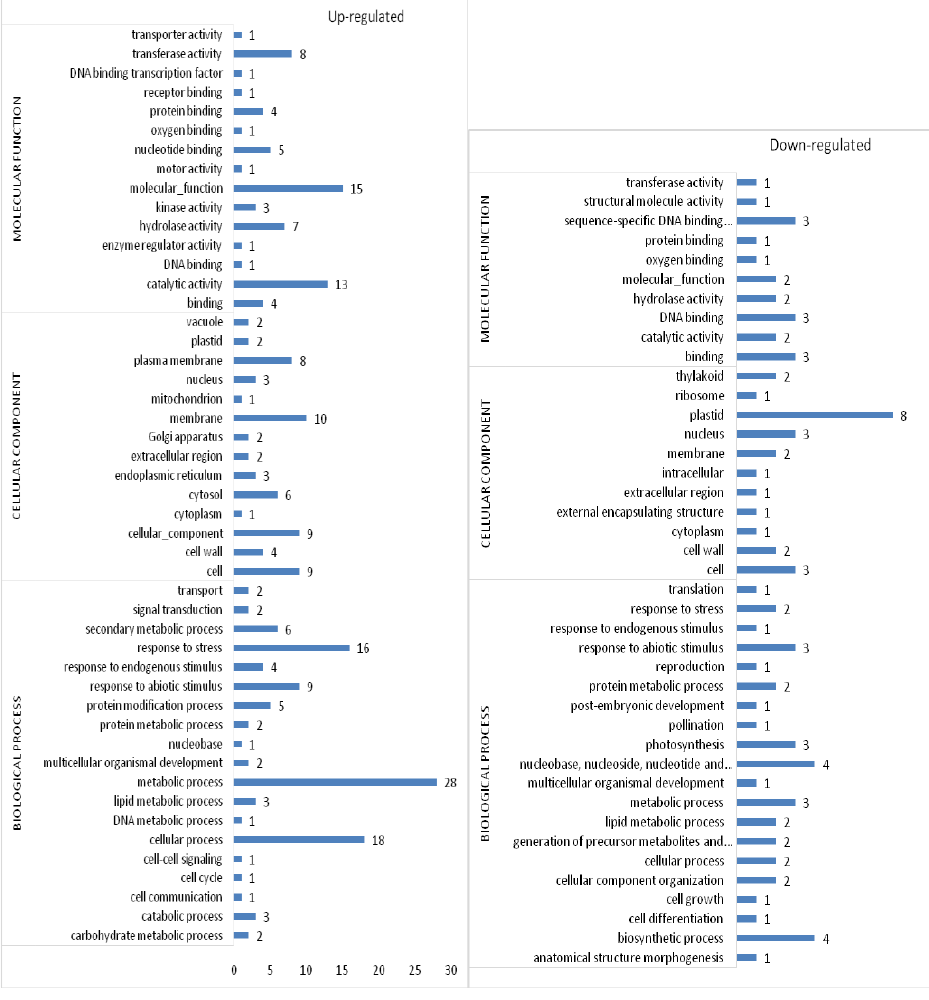
Figure 7. GO classification of differentially expressed up- and downregulated genes. The genes involved in biological process, cellular component, and molecular function. The x-axis indicates the number of genes involved.